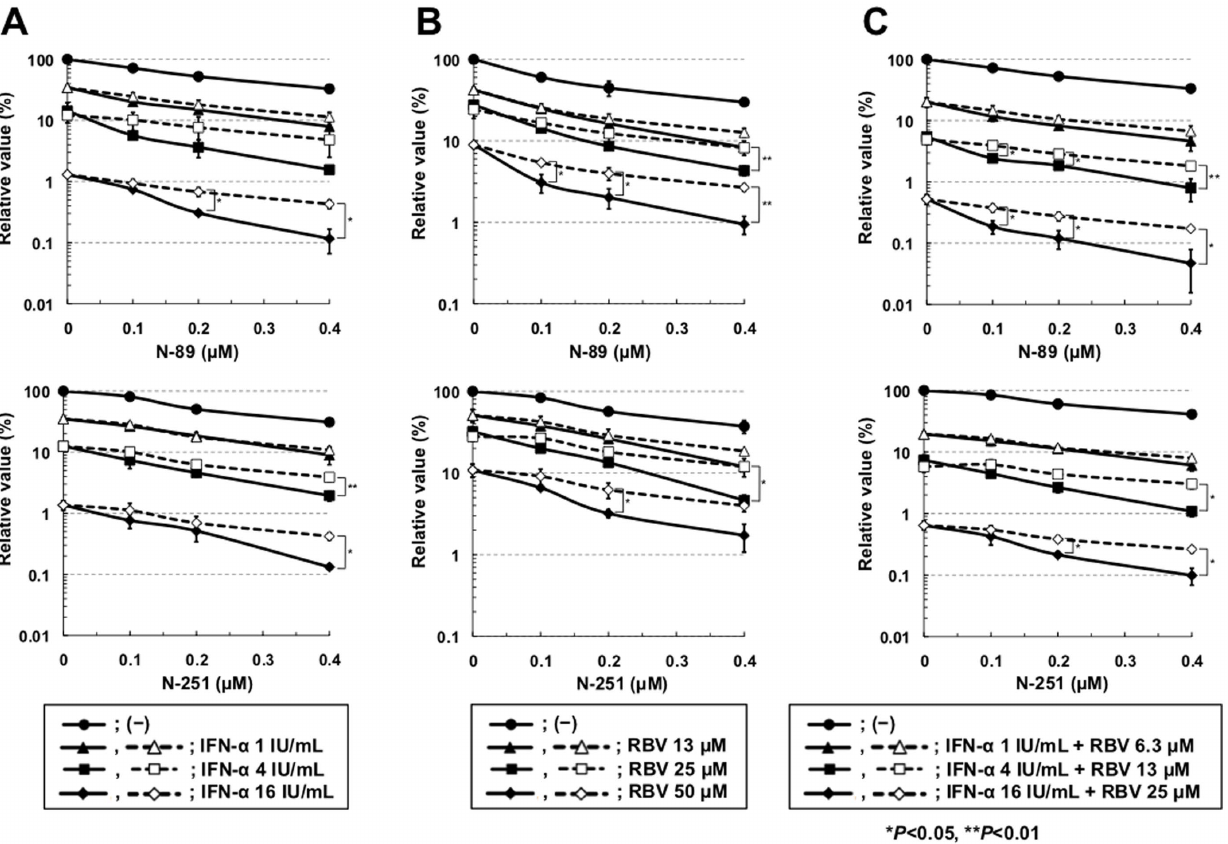
Figure 6. Synergistic anti-HCV effects of N-89 or N-251 in combination with IFN- a and/or RBV on HCV-RNA replication in ORL8 cells. Open symbols in the broken lines show the values expected as an additive anti-HCV effect and closed symbols in the solid lines show the values obtained by the ORL8 assay. ORL8 cells were treated with N-89 (upper panel) or N-251 (lower panel) in combination with IFN- a (A), RBV (B), or IFN- a and RBV (C) for 72 hrs and subjected to RL